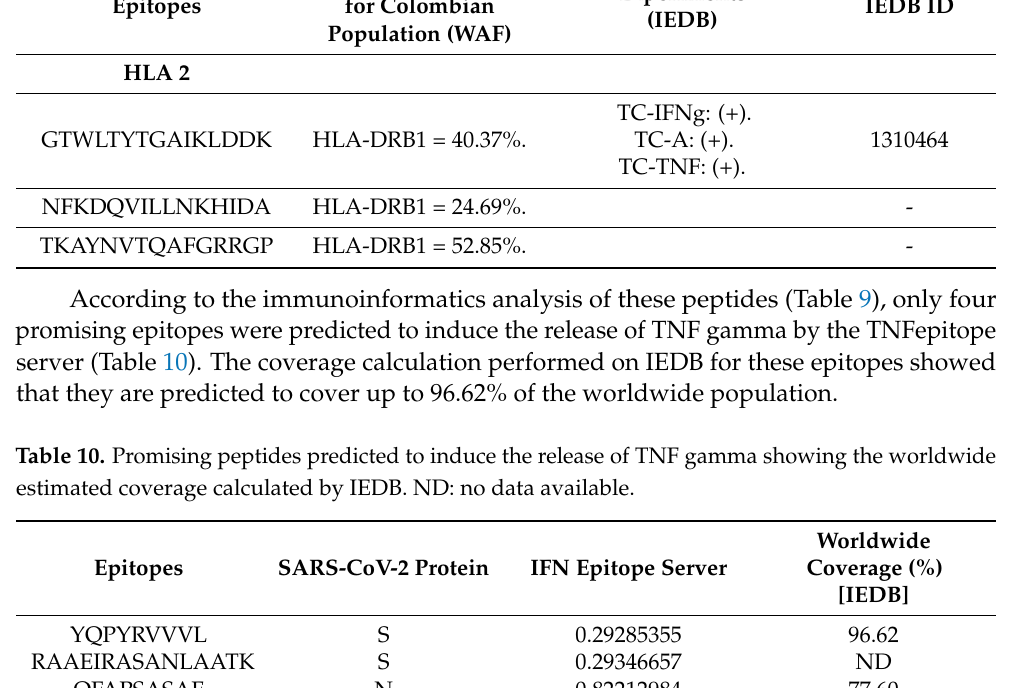
Table 9. Cont. Epitopes